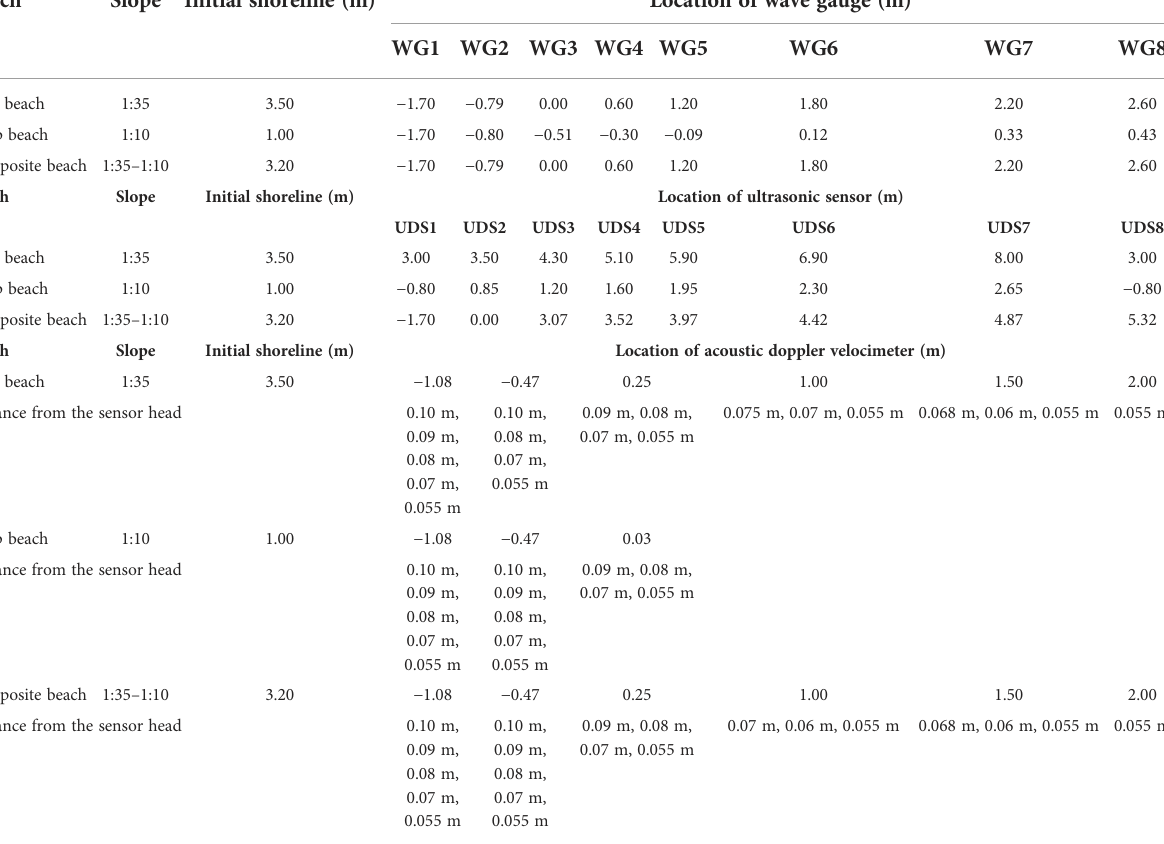
TABLE 1 Locations of wave gauge, ultrasonic sensor and acoustic doppler velocimeter along the x-axis Beach Slope Initial shoreline